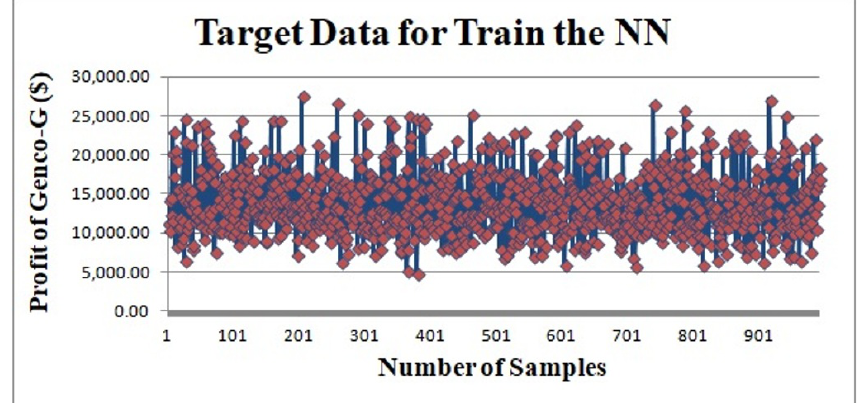
Figure 14. Target data for training the Neural Network.